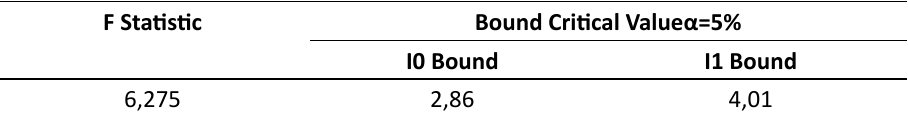
Table 4: Bound Cointegration Test Result